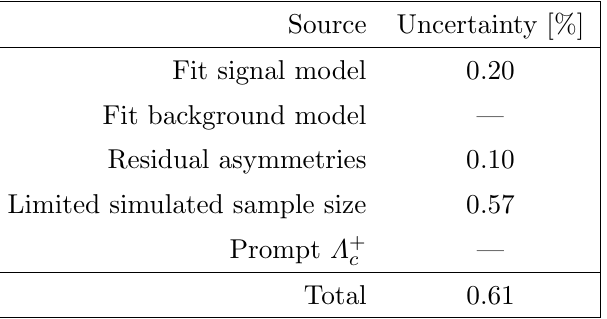
and their magnitudes. The dash indicates that the CP